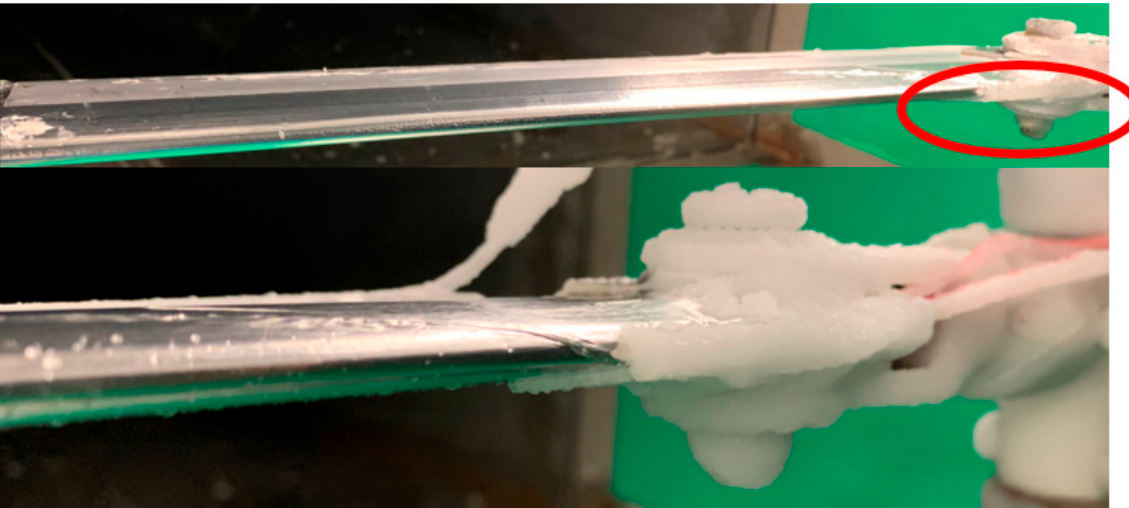
Figure 17. Short layer of ice remaining on the blade after ice shedding during de-icing tests.